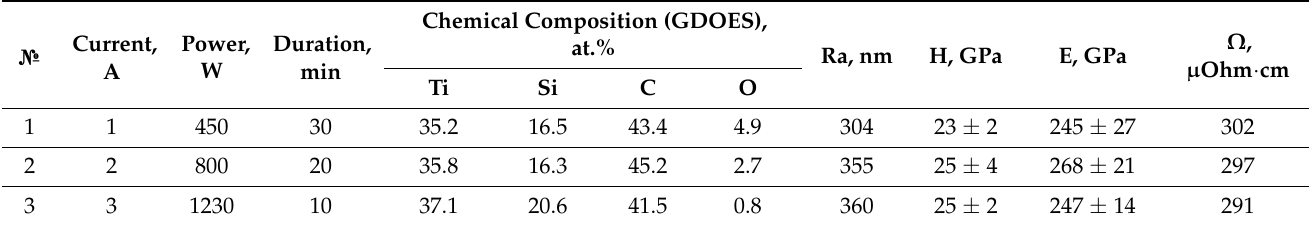
Table 1. Composition and mechanical properties of the